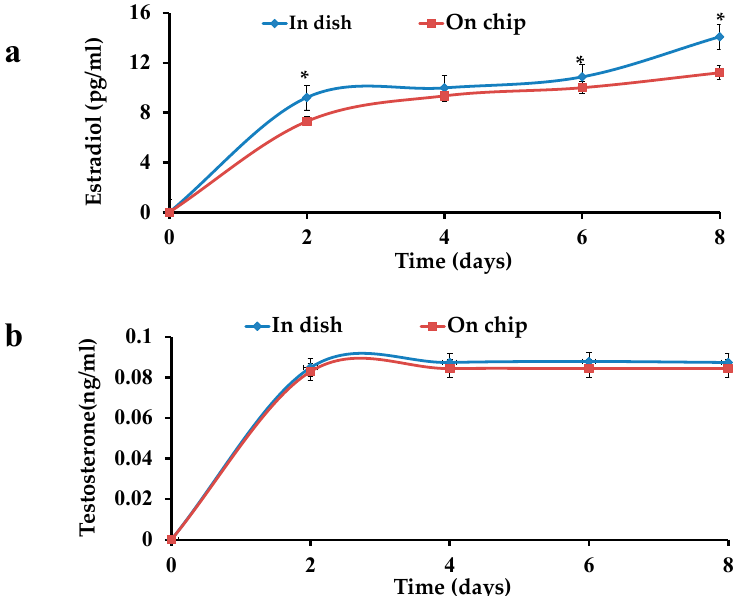
Figure 5. Hormone tests of OFs: ( a ) increase in estradiol level in a dish and on a chip; ( b ) Testtosterone in a dish and on chip.